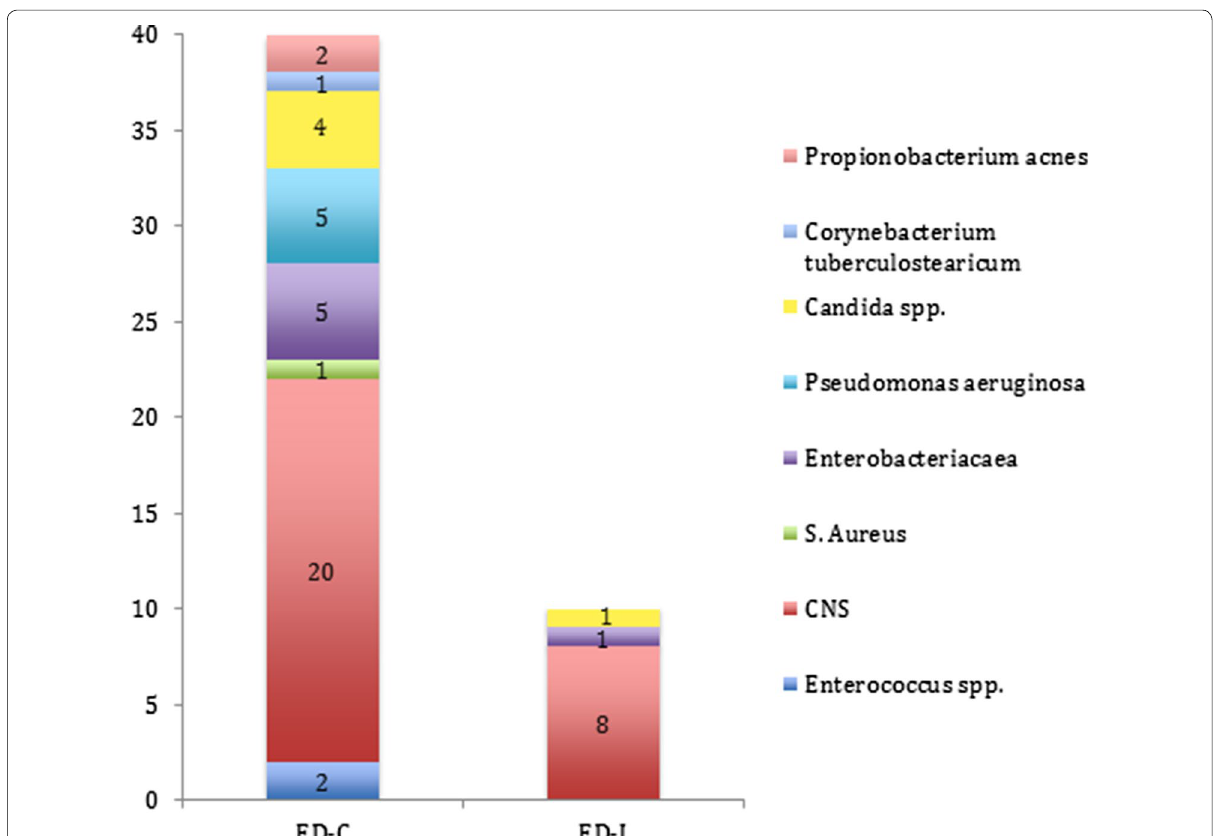
Fig. 3 Micro‑organisms associated with ECMO device colonisations and infections. CNS Coagulase‑negative staphylococci. Seven cannulas were colonised with two different micro‑organisms corresponding to 33 cannula colonisations and a total number of 40